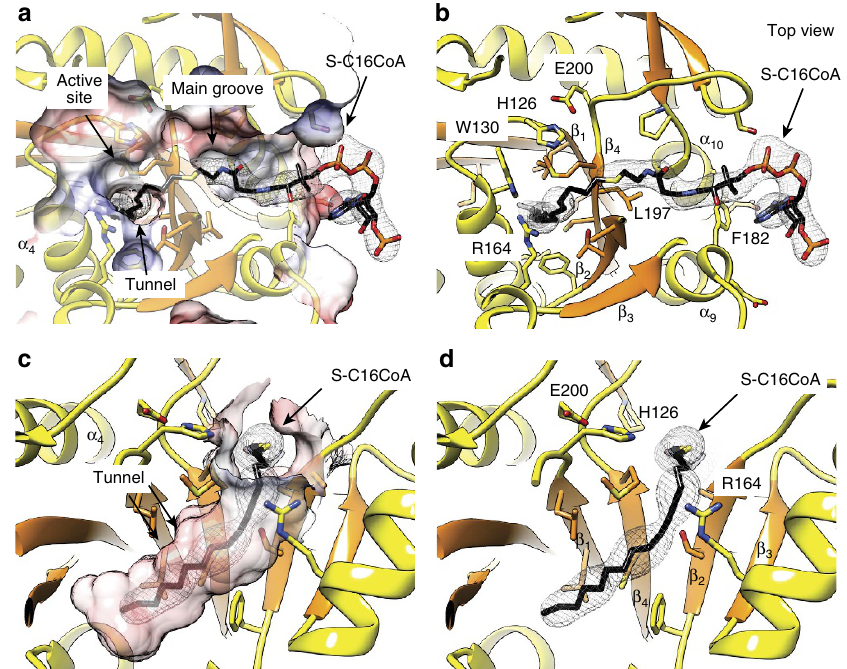
Figure 4 | The palmitoyl–CoA binding site of PatA. ( a – d ) Four views of PatA-S-C16CoA crystal structure showing the binding mechanism of S-C16CoA. The palmitoyl moiety is deeply buried into the hydrophobic tunnel, whereas the coenzyme A moiety extends outwards through the side of the main groove. The 2mFo-DFc electron density map countered at 1 s for the palmitate ligand is shown.